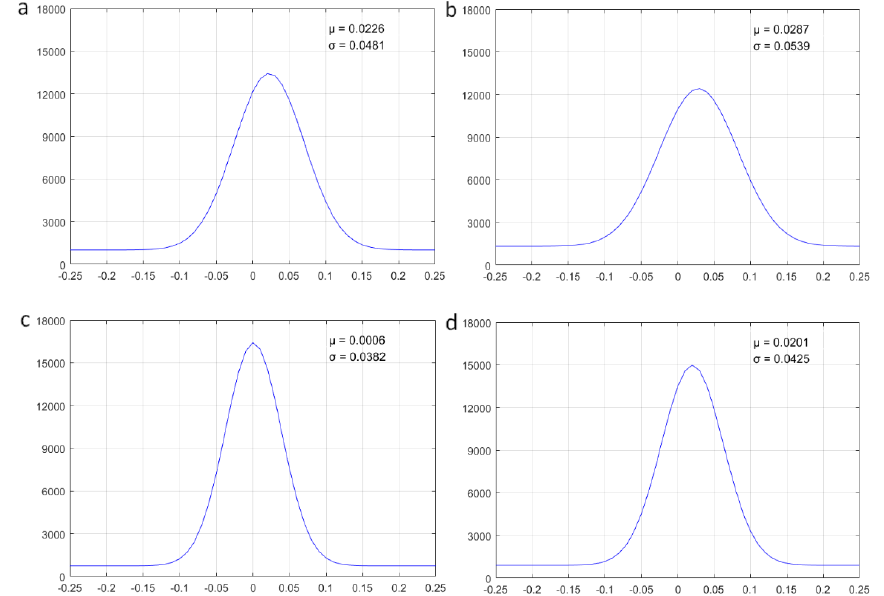
Figure 11. Difference image histogram of the difference map. ( a , b ) were obtained by Expt.1 and Expt.2 on 10 July, respectively, and ( c , d ) were obtained by Expt.1 and Expt.2 on 21 August, respectively.